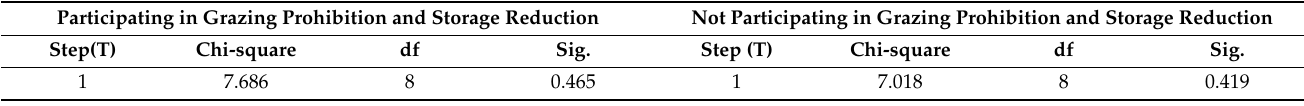
Table 9. Hosmer-Lemeshowtest of classification